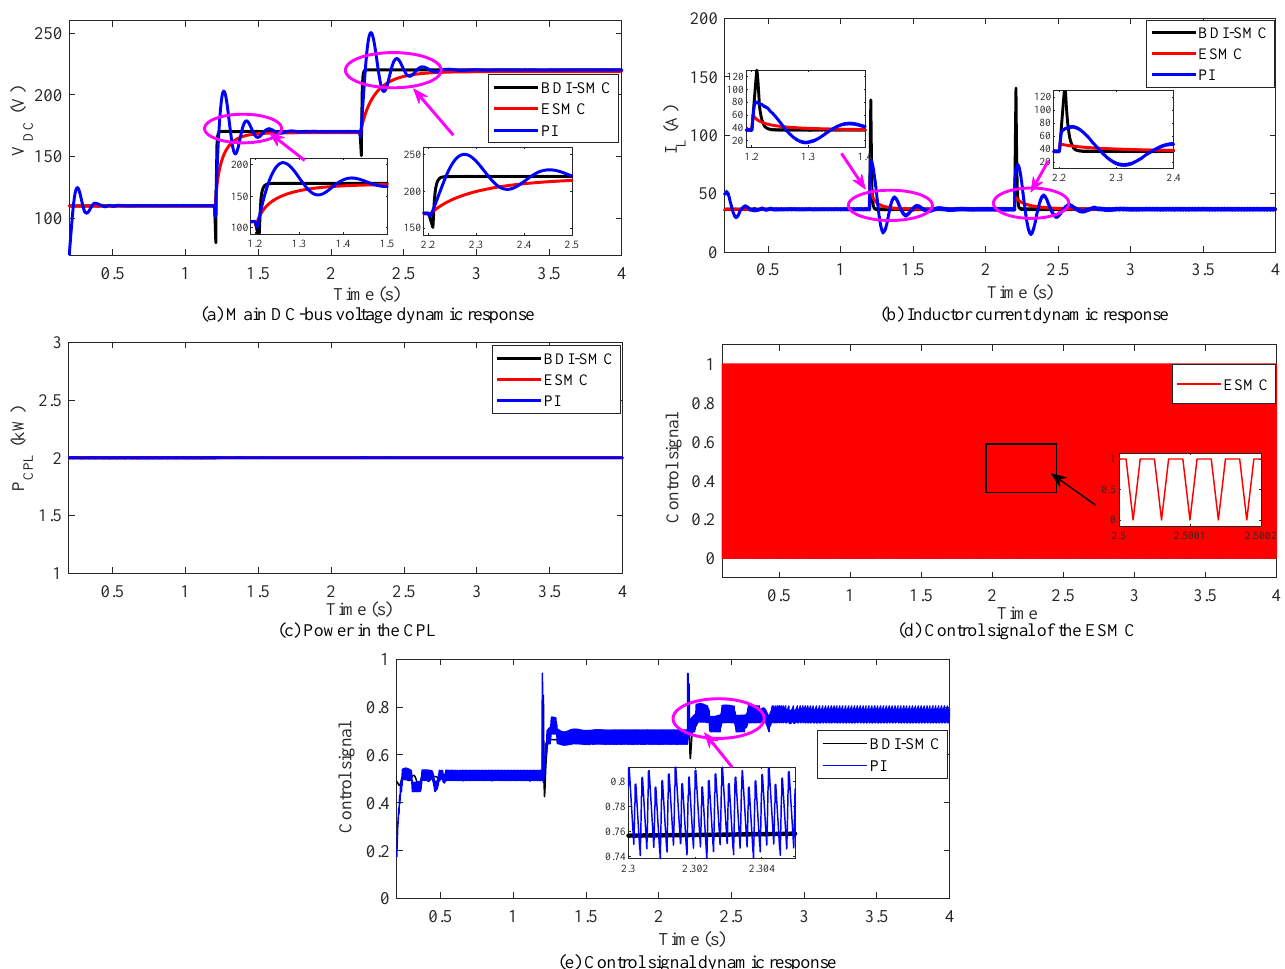
Figure 4d,e. Throughout this simulation study, the load power is constant due to the electrical characteristics of the CPL, which is shown in Figure 4c.